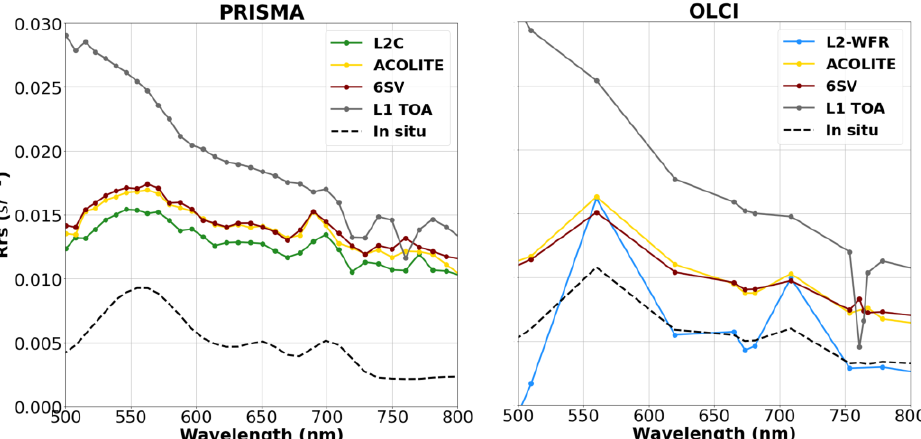
Figure 2. Qualitative comparison of in situ R rs and PRISMA and OLCI AC-corrected R rs on 3 October 2021 for each atmospheric correction algorithm tested.